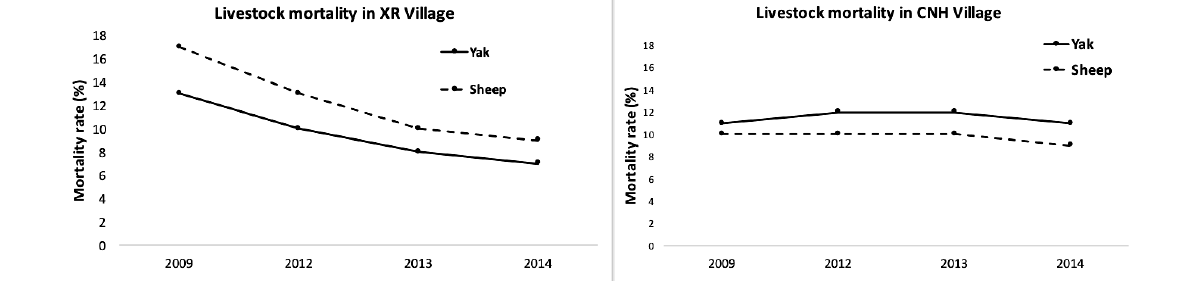
Fig. 3 . Household average livestock mortality changes between 2009 and 2014 in XR and CNH Villages. Despite periods of drought, CNH Village did not see an increase in livestock mortality, while in XR Village there was an obvious decline in mortality.